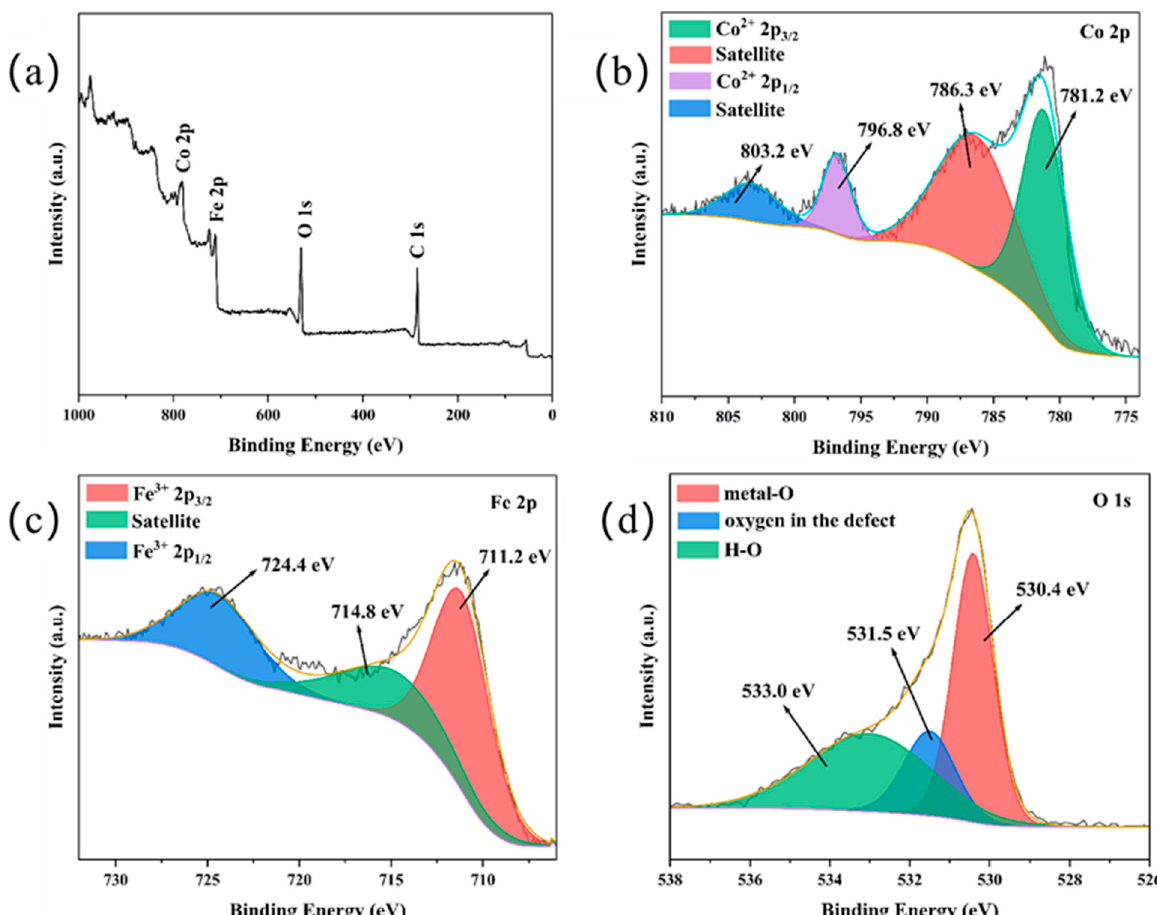
Figure 5. XPS spectra of CoFe 2 O 4 /SWCNTs composites: ( a ) full spectrum, ( b ) Co 2p, ( c ) Fe 2p, and ( d ) O 1s.